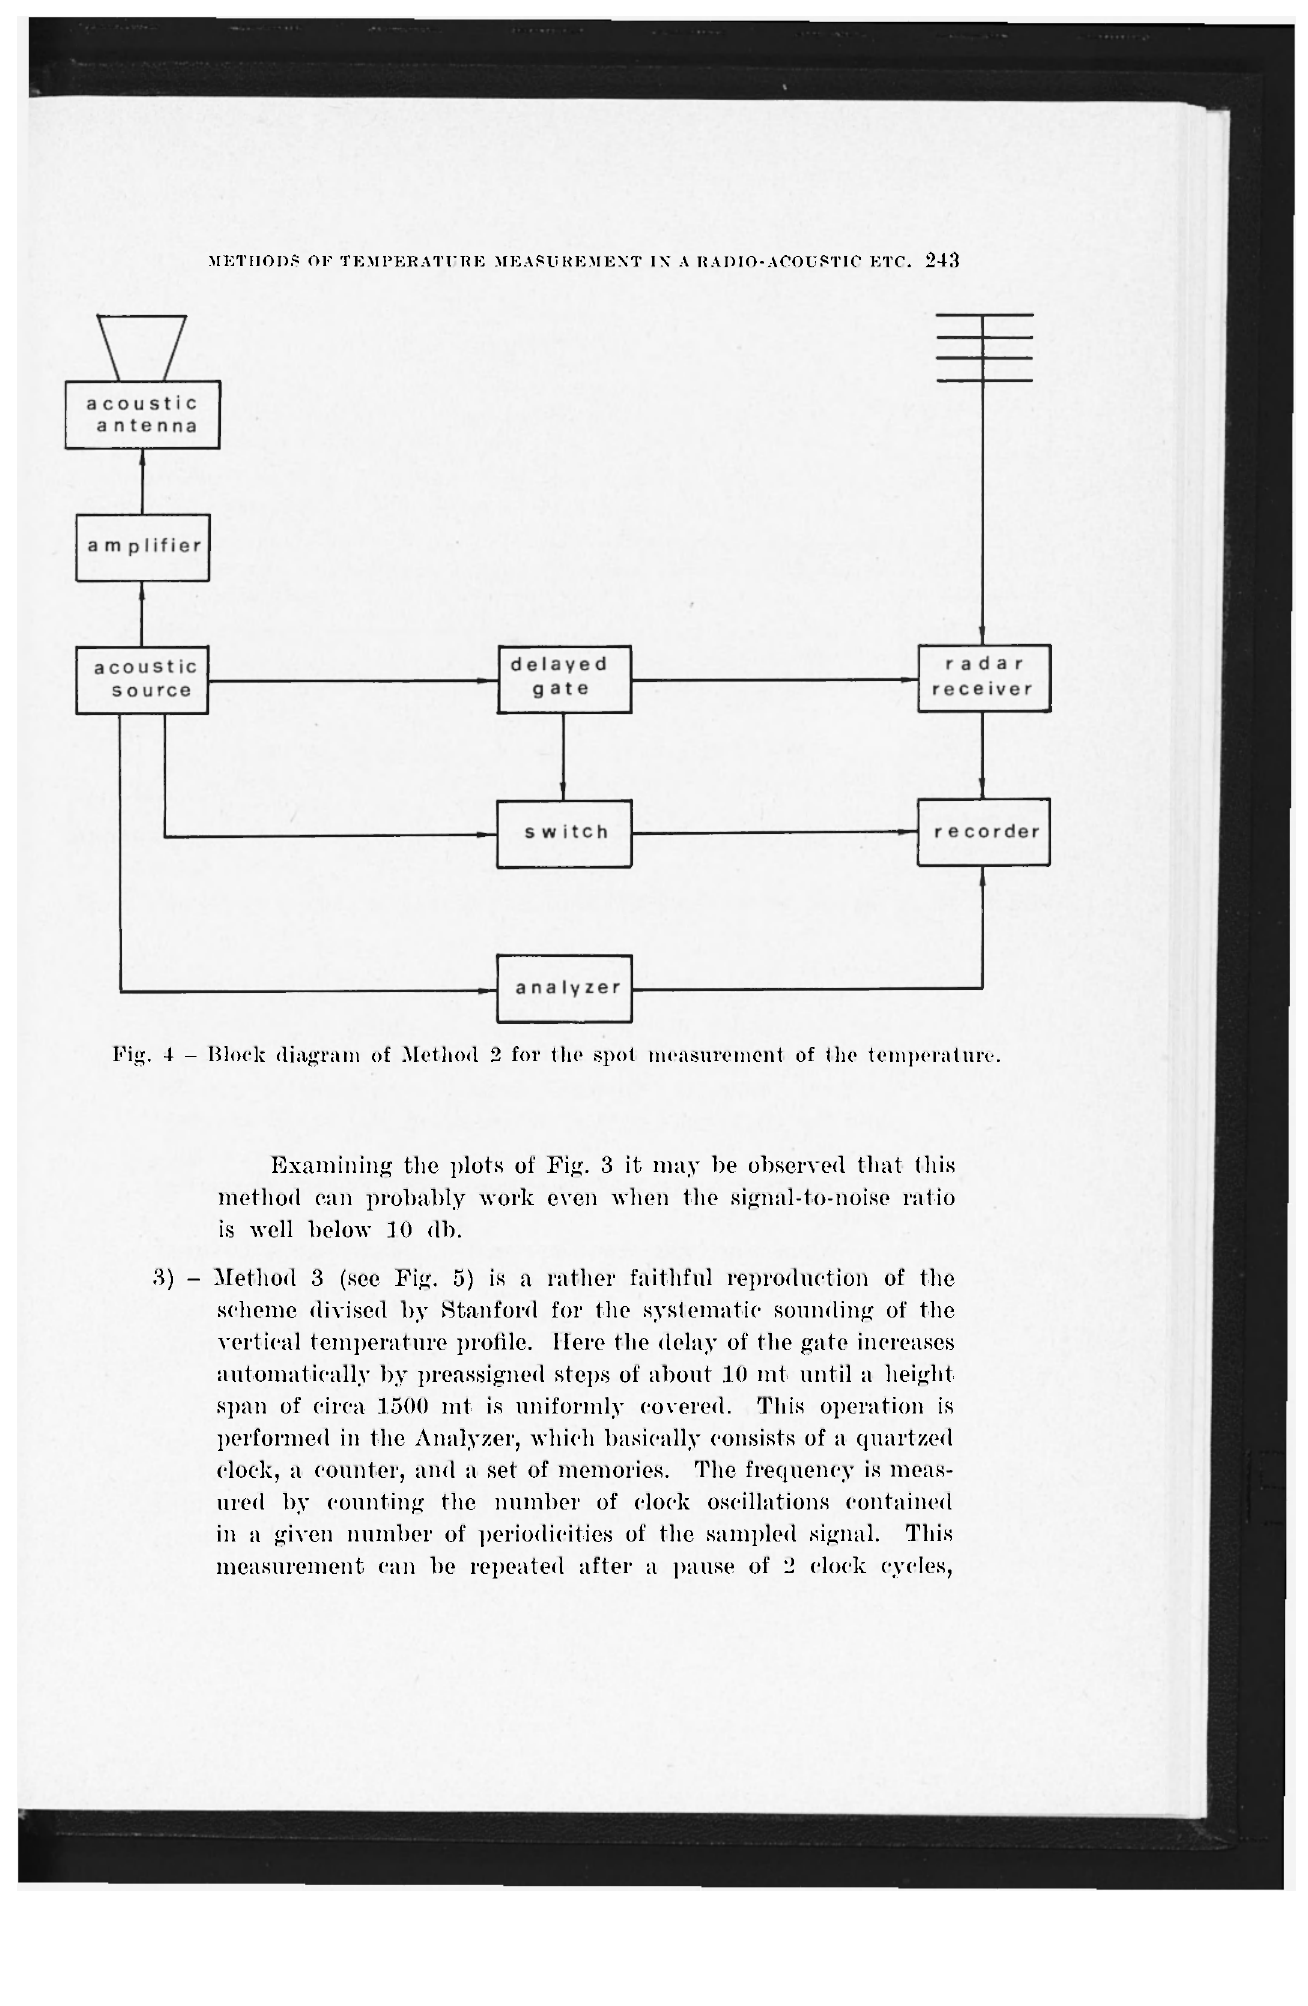
Fig. 4 - Block diagram of Method 2 for the spot measurement of (lie temperature.